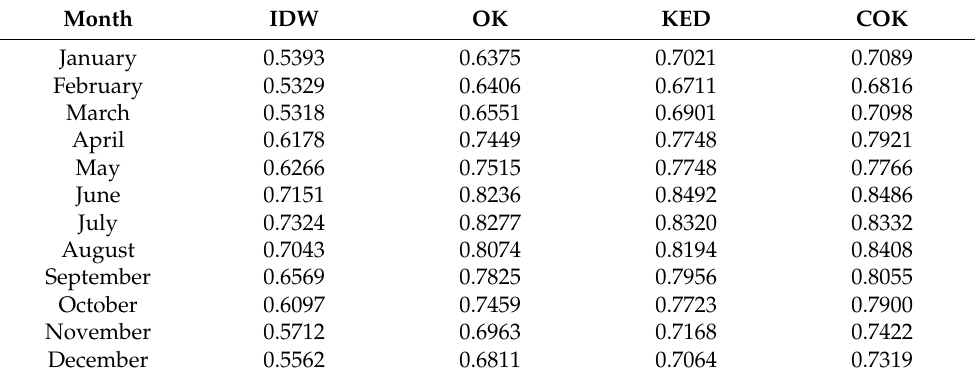
Table 2. Coefficient of determination (R 2 ) of measured versus predicted monthly rainfall for the different interpolation methods (inverse distance weighting, IDW; ordinary kriging, OK; kriging with an external drift, KED; ordinary cokriging, COK).